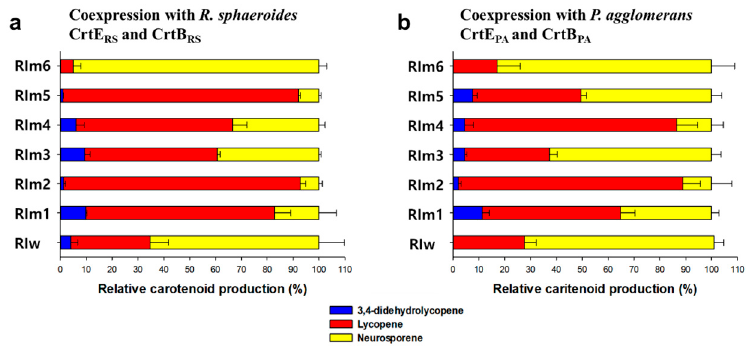
Figure 2. Relative carotenoid profiles in E. coli strains coexpressing six CrtI RS mutants with ( a ) R. sphaeroides CrtE RS and CrtB RS and ( b ) P. agglomerans CrtE PA and CrtB PA . Blue, red, and yellow bars represent 3,4-didehydrolycopene, lycopene, and neurosporene, respectively. RIw refers to a wild-type CrtI RS . Data are expressed as the mean ± SD. Table 1. Strains and plasmids used in this study.